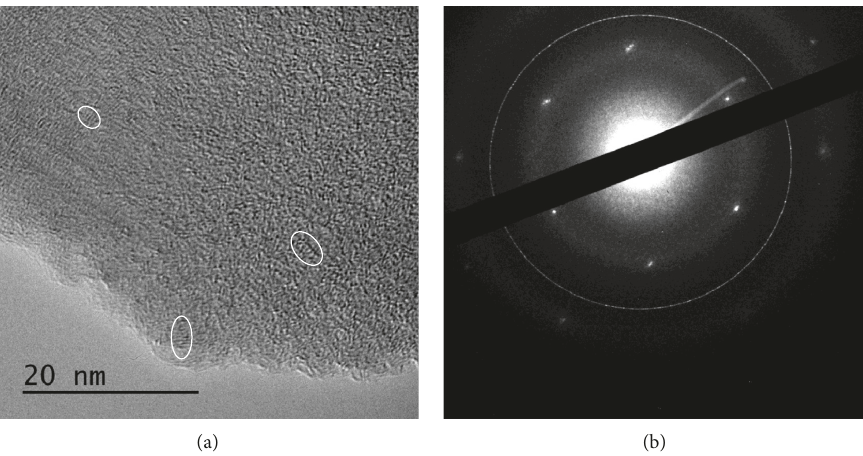
Figure 9: (a) HRTEM image of the Gr 2 fraction (some 3D stacks are highlighted with ovals). (b) Electron diffraction